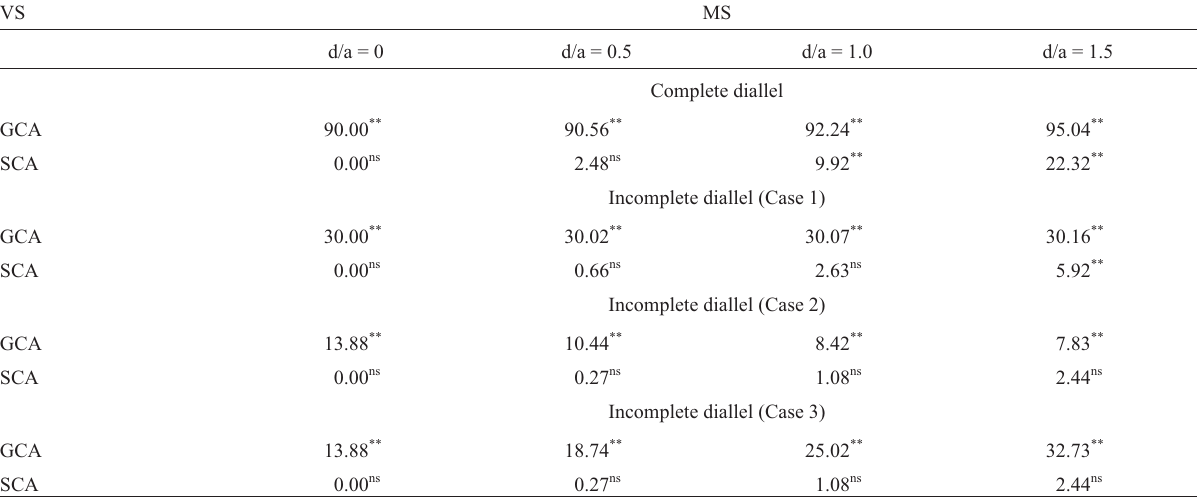
Table 5 - Summary of the complementary analysis of variance of the complete and incomplete diallels for several mean degrees of dominance.